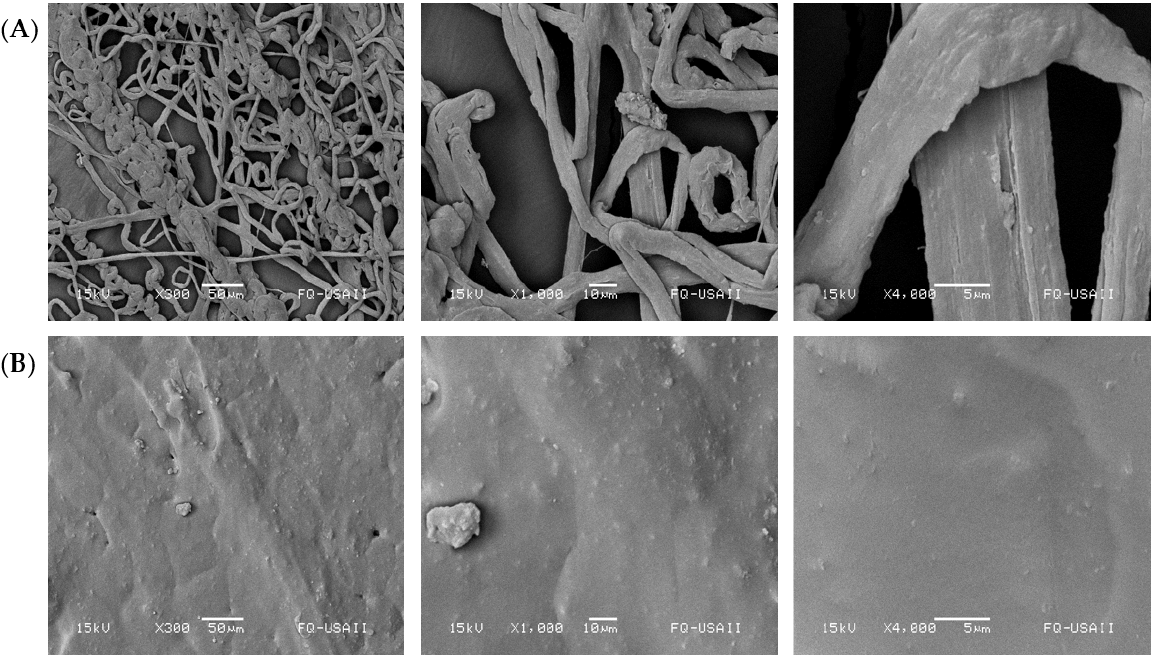
Figure 3. Morphological of the generated scaffolds, ( A ) the conventional method (Control), ( B ) the ethanol–acetone.